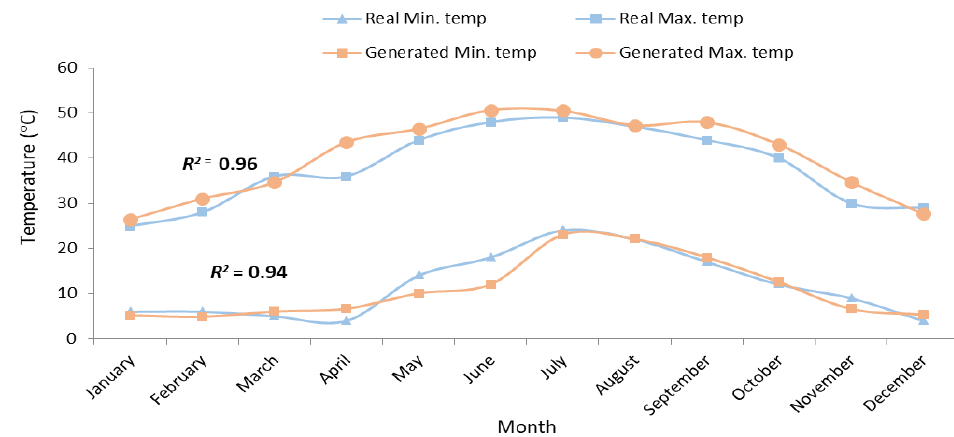
Figure 3. Real (1992 – 2019) vs. generated (2020 – 2070) mean temperature.